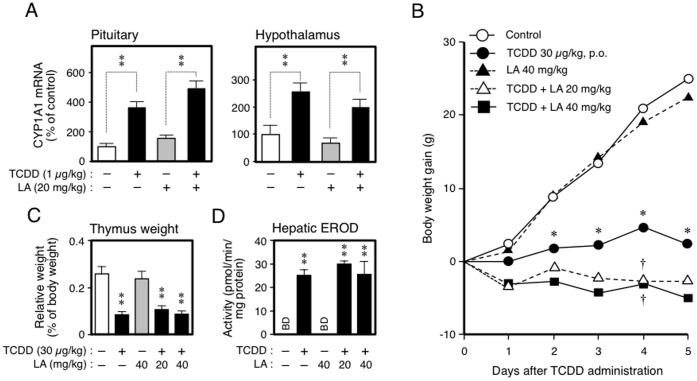
The effects of LA on the induction of fetal brain CYP1A1 and on the acute toxicity of TCDD in pubertal rats.A, Pituitary and hypothalamic CYP1A1 mRNAs in the fetuses (GD20), the parents of which were treated with TCDD (GD15) and LA (GD15-20). B-D, Change in body weight (B), thymic weight (C) and hepatic EROD activity (D) of male pubertal rats treated orally with TCDD (Day 0) and intravenously with LA (from Day 0 to Day 5). In Experiment (B), the initial body weights of rats in the control, TCDD, LA, and TCDD + LA-treated groups were 219±6, 218±6, 216±7, 216±8 (LA: 20 mg/kg), and 217±5 (LA: 40 mg/kg) g, respectively. The thymus and liver were removed 30 min after the last administration of LA or vehicle. Each bar or plot represents the mean ± SEM (N = 5 or 6). To avoid confusion, the error bar was omitted from panel B. *p<0.05 and **P<0.01, compared with the control, and †P<0.05 compared with the TCDD-treated group. B.D.: below the determination limit (4 pmol/min/mg protein).